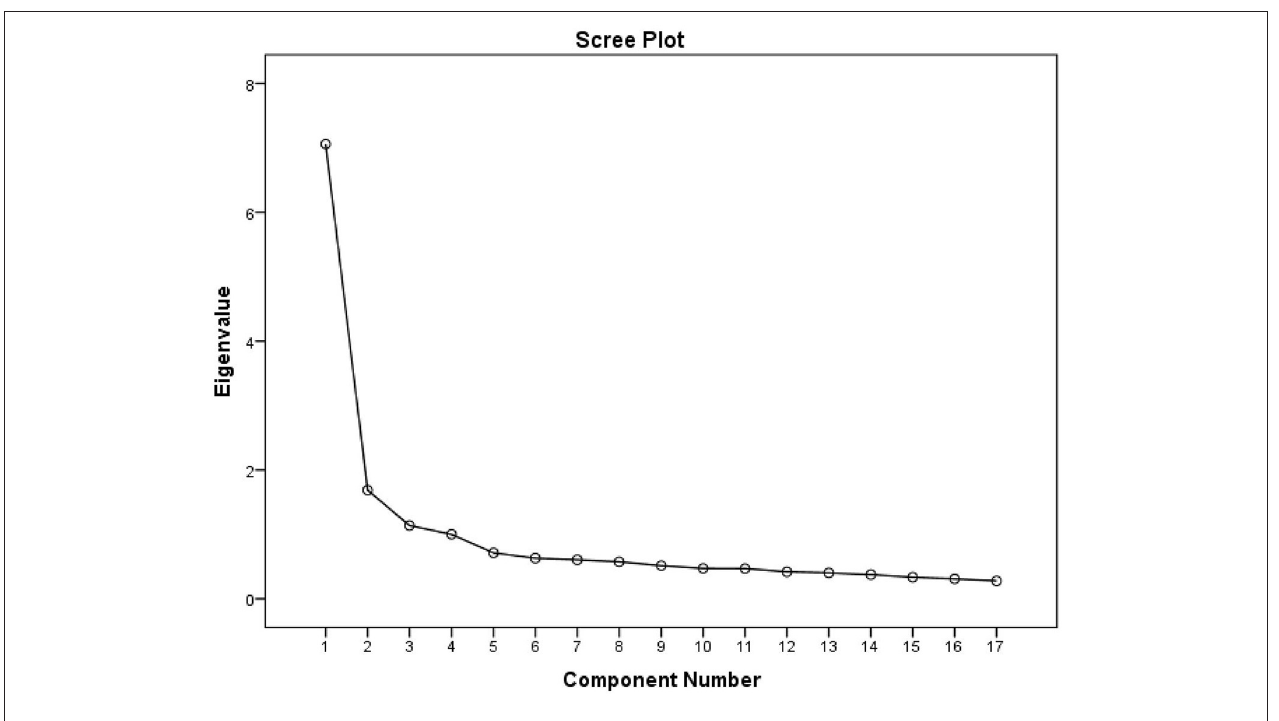
FIGURE 2 | Scree plot of exploratory factor